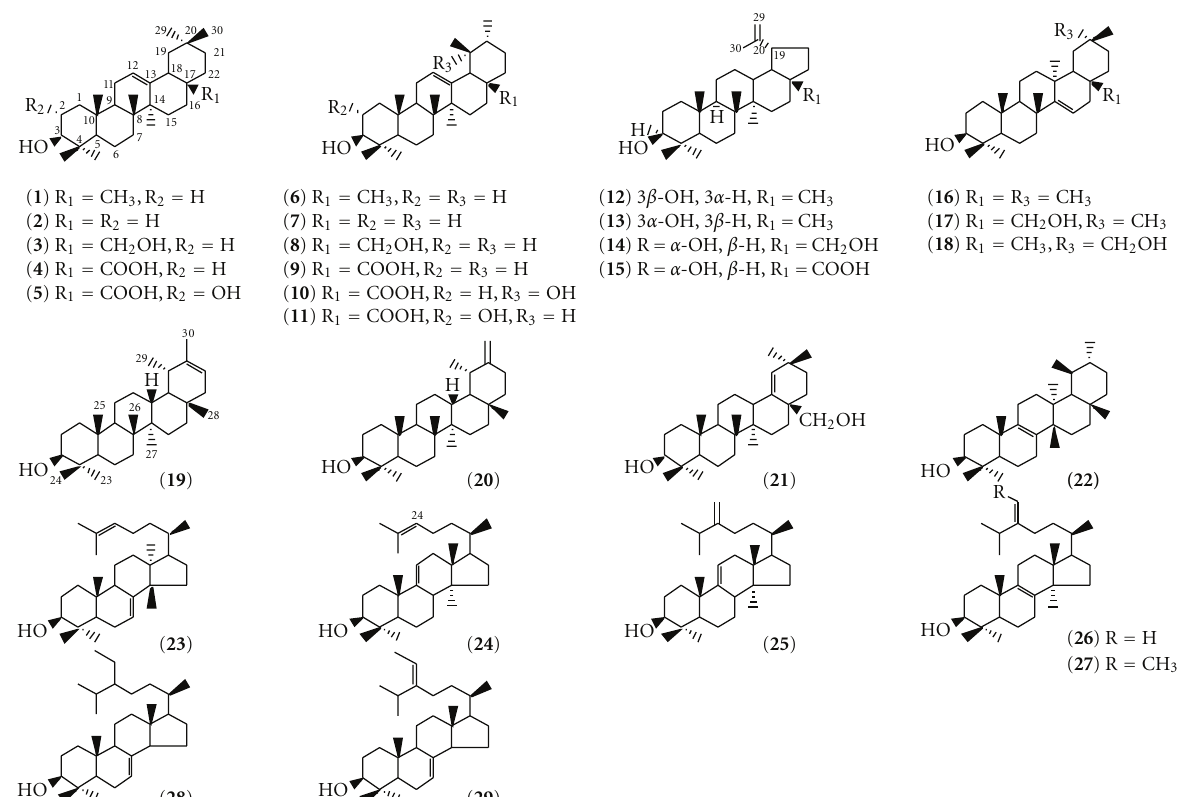
Scheme 1: Structures of nonsterol triterpenoids cited in the